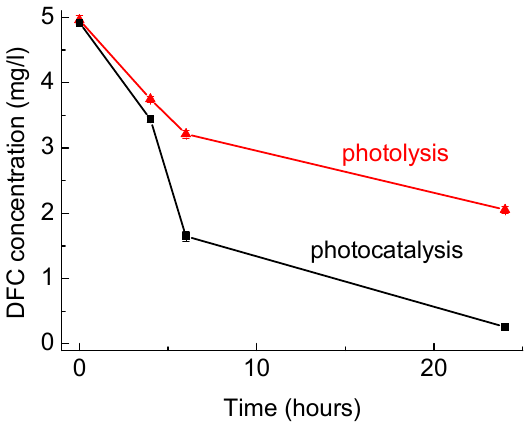
Figure 1. Diclofenac (DCF) photodegradation over time by UV photolysis (no photocatalyst) and UV photocatalysis employing hydroxyapatite and TiO 2 (HApTi) catalyst in solution (DCF concentration 5 ppm; HApTi catalyst concentration 4 g/L). Error bars refer to standard deviation of duplicate samples.